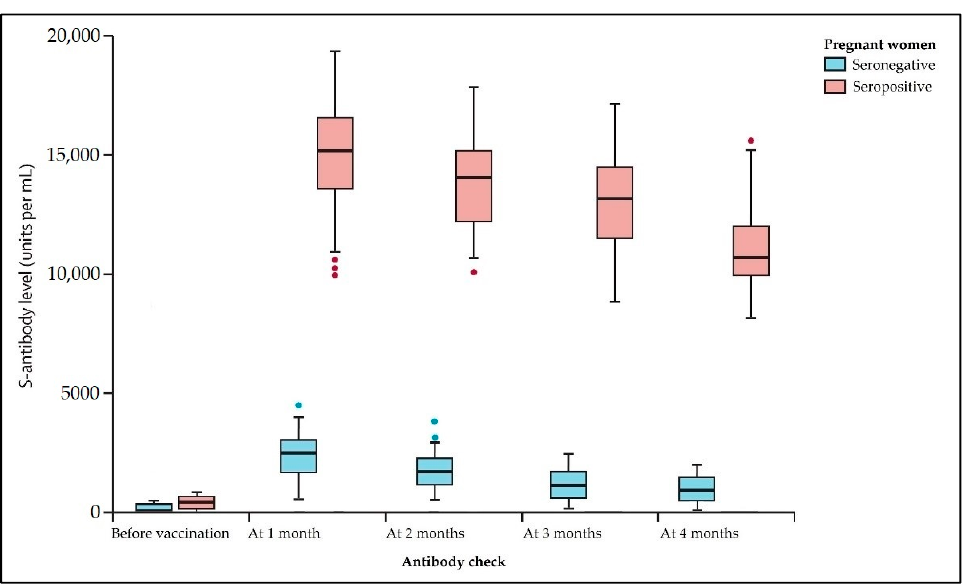
Figure 2. Boxplot comparison of spike antibodies in seronegative vs. seropositive pregnant patients. Data was evaluated in a seriated fashion, being followed before vaccination every month until 4 months. Median values and Interquartile Range are represented inside the box; minimum, maximum, and outliers are shown outside the box.